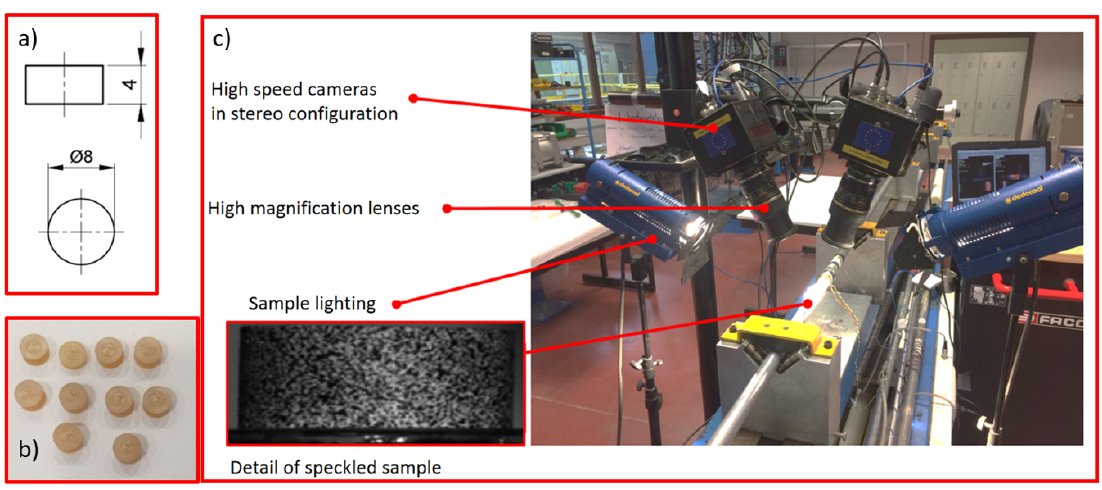
Figure 3. ( a ) Dynamic compression test sample geometry, ( b ) picture of the manufactured samples, and ( c ) detail of the split Hopkinson pressure bar setup used for the dynamic compression tests.